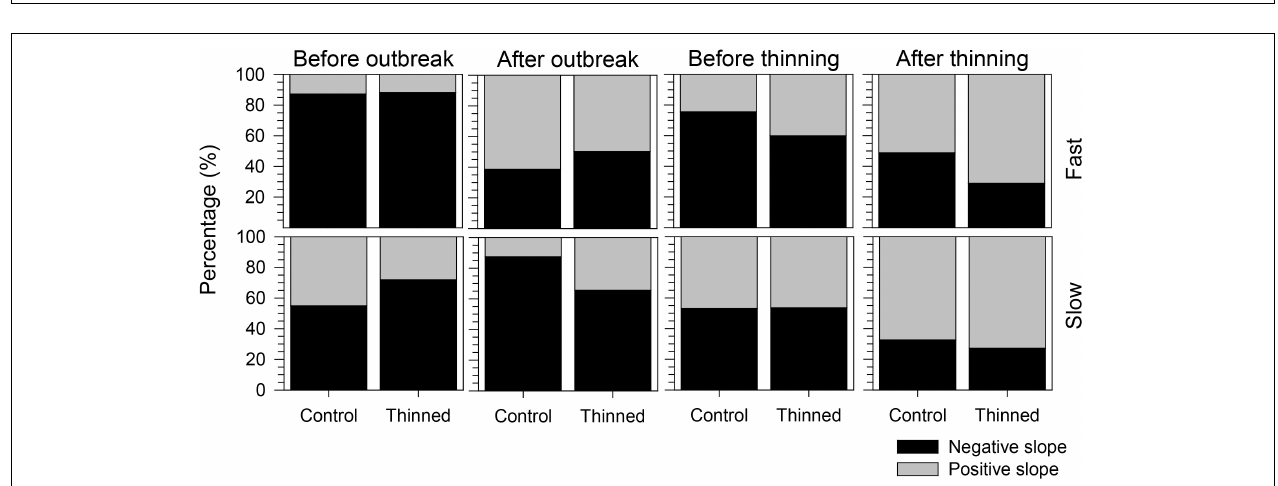
FIGURE 5 | Slope of the regressions calculated during the four years before and after spruce budworm outbreak and thinning. Box plots represent the median, drawn as a horizontal solid line, with upper and lower quartiles and whiskers achieving the 10th and 90th percentiles.